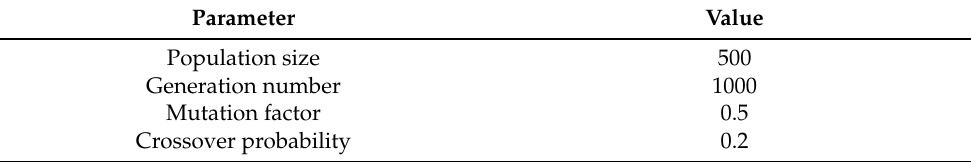
Table 3. Simulation parameters [25,27,28]. Parameter Value FOV at a receiver, ψ c PD detection area, A